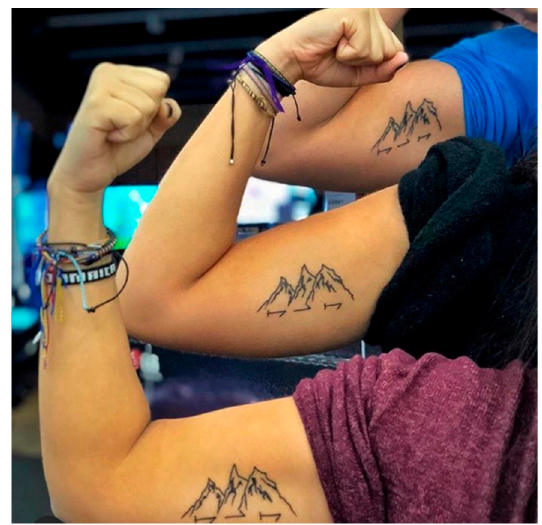
Figure 4. Kelly’s tattoo, matching with her siblings.